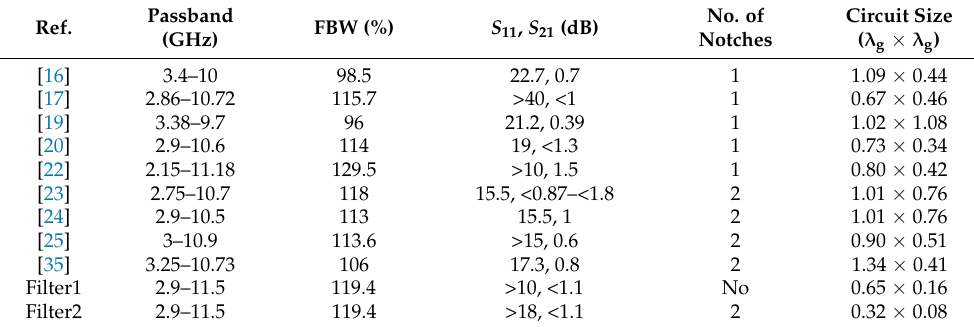
Table 2. Comparison with other reported work.